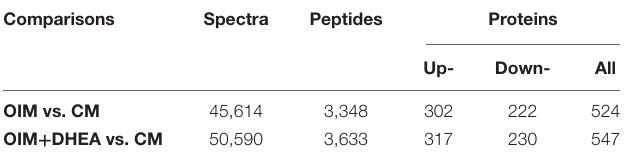
TABLE 2 | Quantitative results of protein. Comparisons Spectra